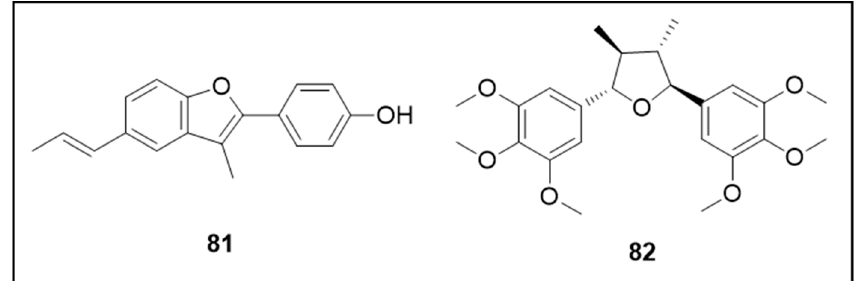
Figure 12 details the neolignan chemical structures.